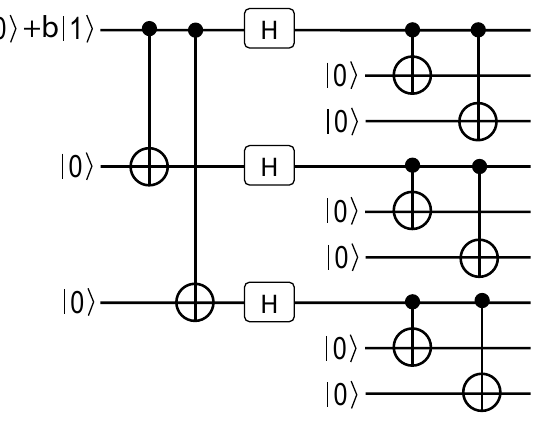
Figure 18: Circuit to generate Shor 9-qubit error-protected state from that of a single qubit. code is then the basis for a three-qubit block, where a qubit in | 0 〉 is encoded as | + ++ 〉 and a